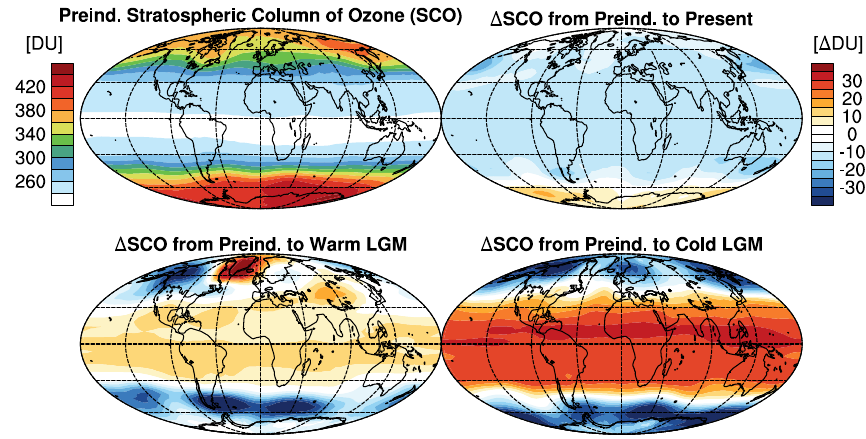
Fig. 11. Preindustrial simulated zonal mean stratospheric ozone columns [DU], and the change in ozone in the present day relative to the preindustrial (top panels). The model does not include the heterogeneous chemistry of the Antarctic ozone hole. Also shown are the changes during the warm and cold simulations of the LGM, relative to the preindustrial (bottom panels). The difference plots share a common color bar.